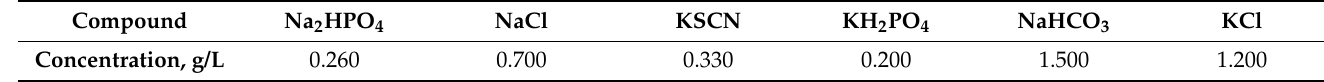
Table 4. SBF: artificial saliva chemical